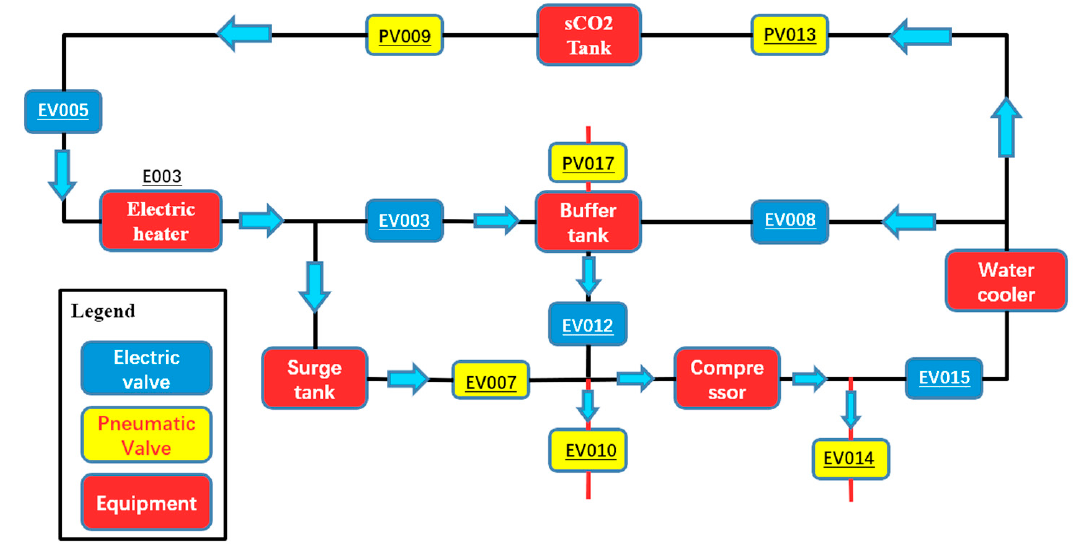
Figure 8. Circle diagram of the general experimental platform.